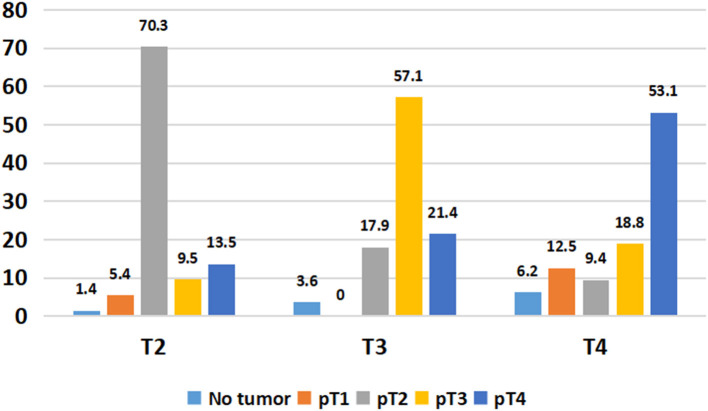
Comparison of preoperative and histopathological staging.